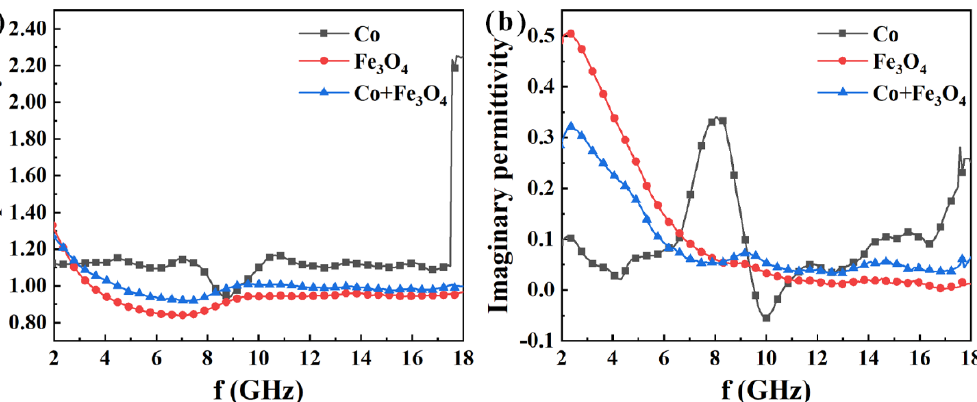
Figure 7. ( a ) Real ( μ ′ ) and ( b ) imaginary ( μ ″ ) parts of the Co, Fe 3 O 4 and Co/Fe 3 O 4 as functions of the frequency.